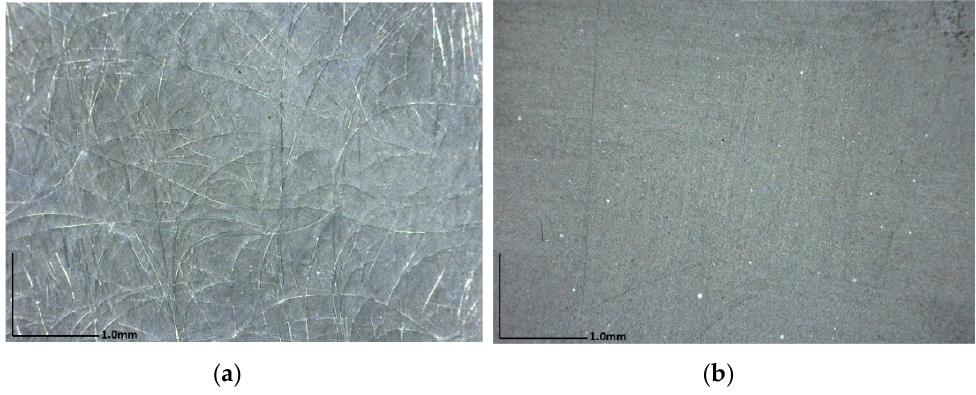
Figure 2. Surface of test specimens magnified 50 times: ( a ) C-SMC and ( b ) CFRP.